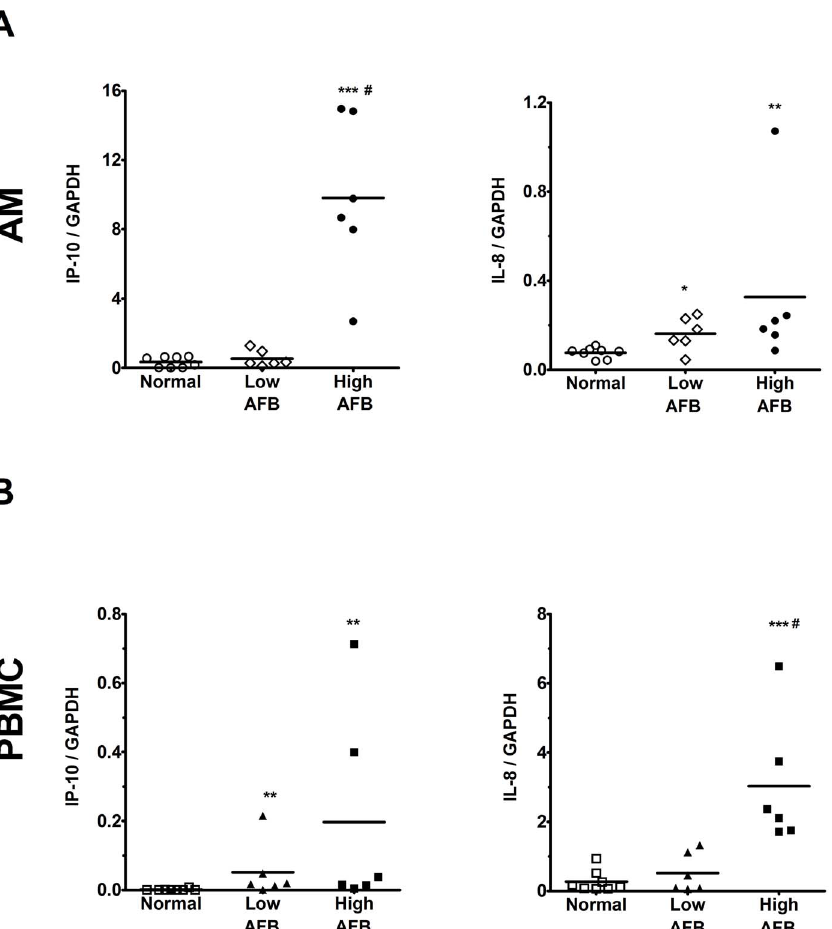
Figure 3. Expression of IP-10/CXCL10 and IL-8/CXCL8 mRNA in AM and PBMC of TB patients. The mRNA levels of IP-10/CXCL10 (left panel) and IL-8/CXCL8 (right panel) in (A) alveolar macrophages (AM) and (B) PBMC of TB patients with high bacterial load (High AFB, n=6) are significantly higher than that of low bacterial load TB patients (Low AFB, n=6) and normal subjects (Normal, n=8). Values were normalized by GAPDH. Data are means 6 SE. *p , 0.05, ** p , 0.01, *** p , 0.001 compared with normal subjects. # p , 0.01 compared with low bacterial load TB patients.